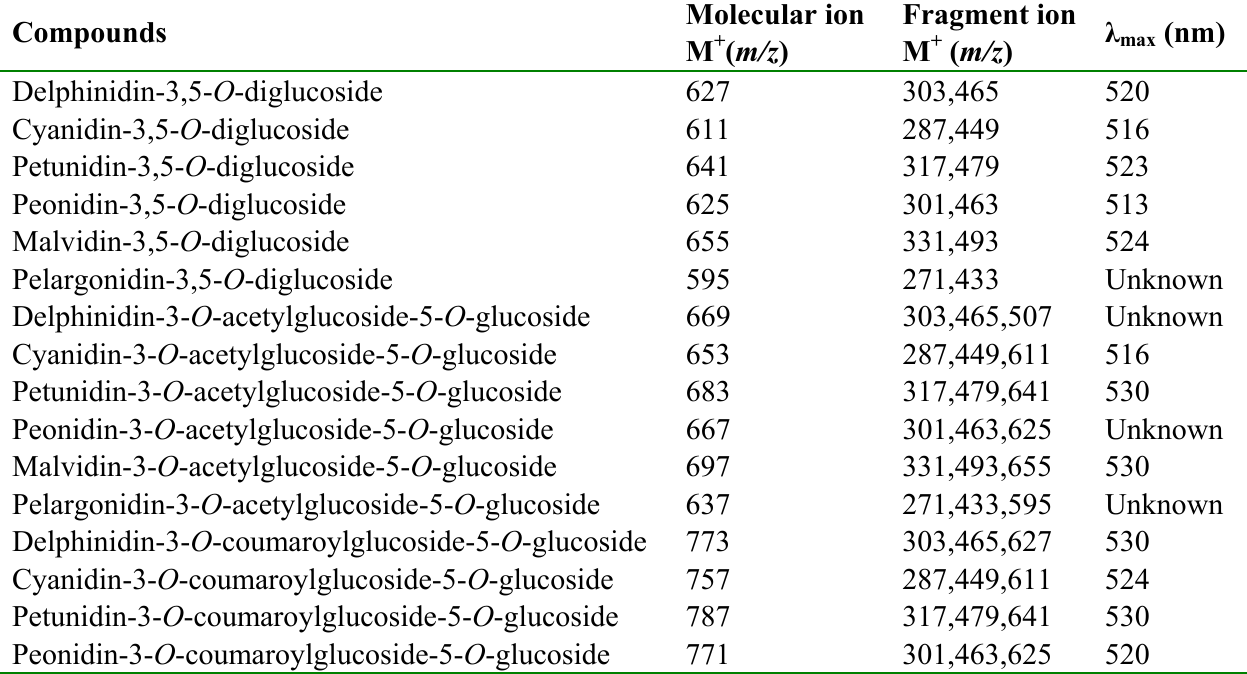
Table 2. The mass spectral and UV-vis data of the major diglucosidic free anthocyanins in various red wines that made from non- V. vinifera grapes